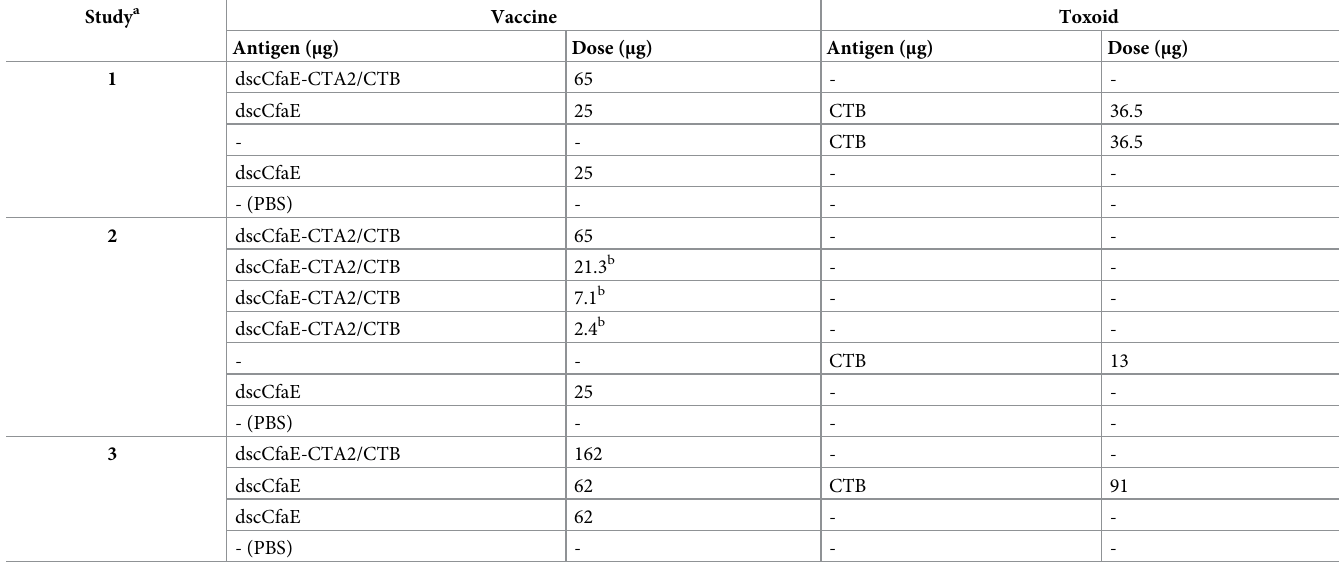
Table 1. Murine experimental study